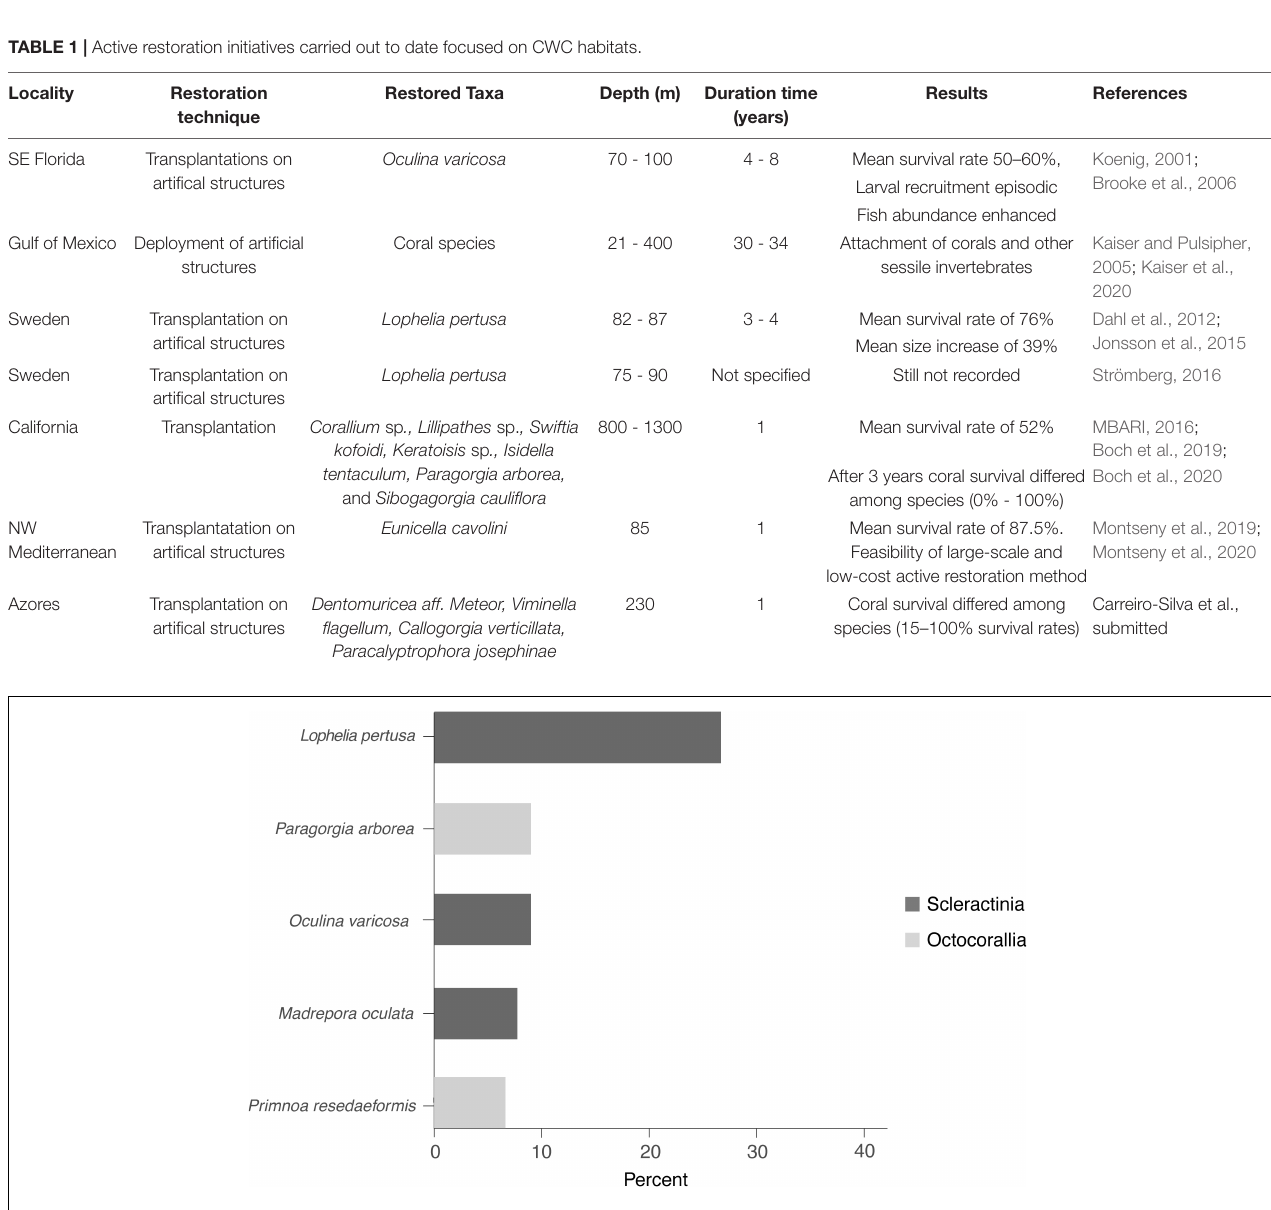
FIGURE 2 | Five most studied coral species in CWC restoration publications ( N =